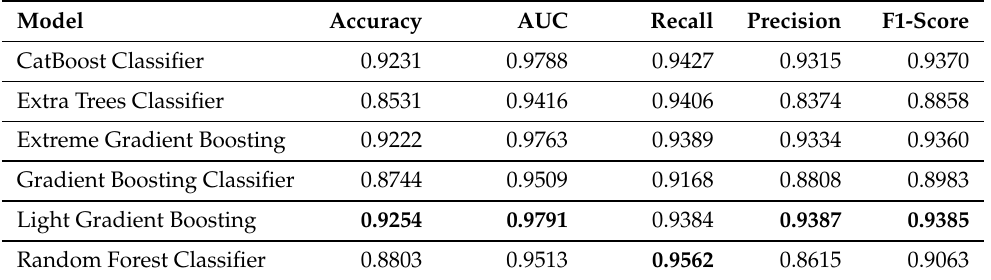
Table 4. Training dataset results (best scores in bold).